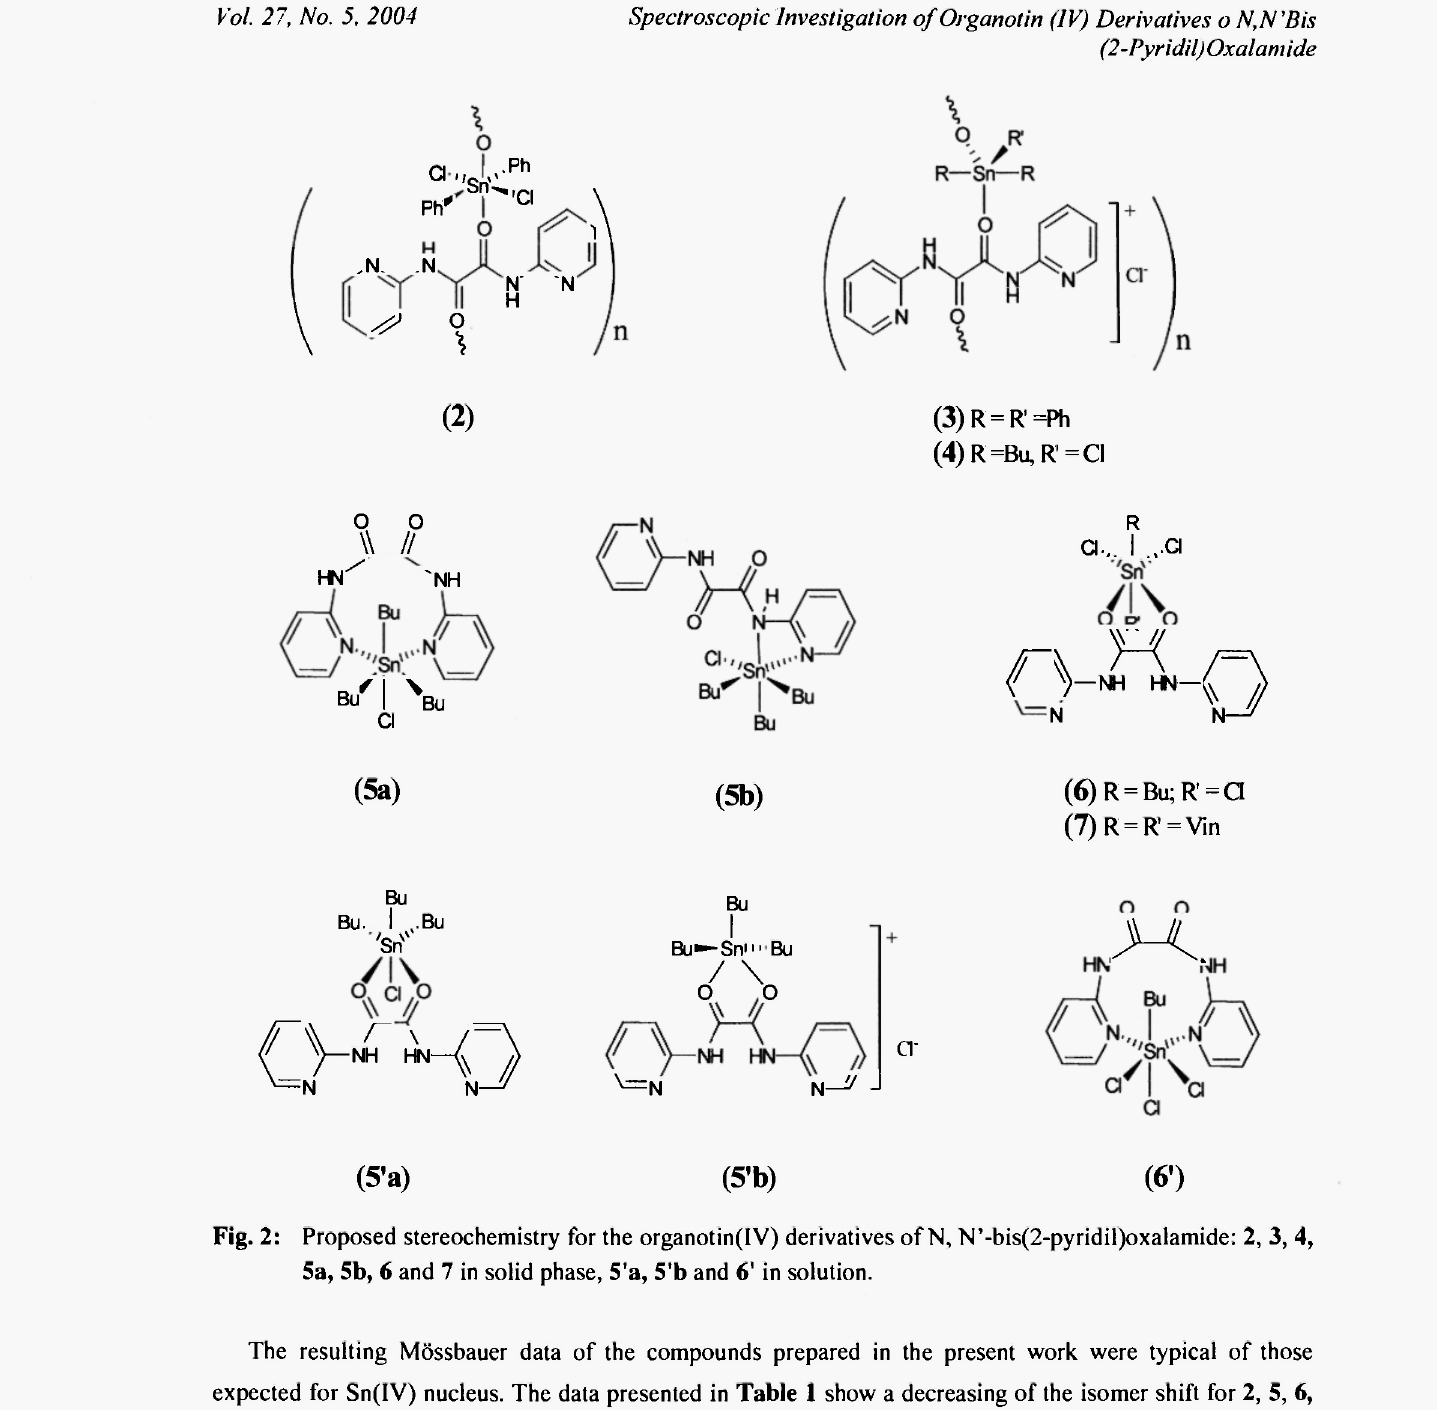
Fig. 2: Proposed stereochemistry for the organotin(IV) derivatives of N, N'-bis(2-pyridil)oxalamide: 2, 3, 4, 5a, 5b, 6 and 7 in solid phase, 5'a, 5'b and 6' in solution. The resulting Mössbauer data of the compounds prepared in the present work were typical of those expected for Sn(IV) nucleus. The data presented in Table 1 show a decreasing of the isomer shift for 2, 5, 6, and 7 upon coordination, but not for 3 and 4. The isomer shift values of the latter two were remarkably close to those of the starting materials. Both SnCl 2 Bu 2 and SnClPhj have the Sn(IV) at the centre of a trigonal- bypiramidal unit /16, 17/. The difference between those is the quadrupole splitting, which is consistent with three phenyl groups attached to the Sn(IV) in 3, whereas in 4 it lies within the range frequently assigned for trans substituent groups /18, 19/. By comparing the isomer shift between 3, 4 and their precursors, the proximity between them leads to a five-coordinate Sn(IV) nucleus as the most most likely arrangement in solid phase for those as shown in Figure